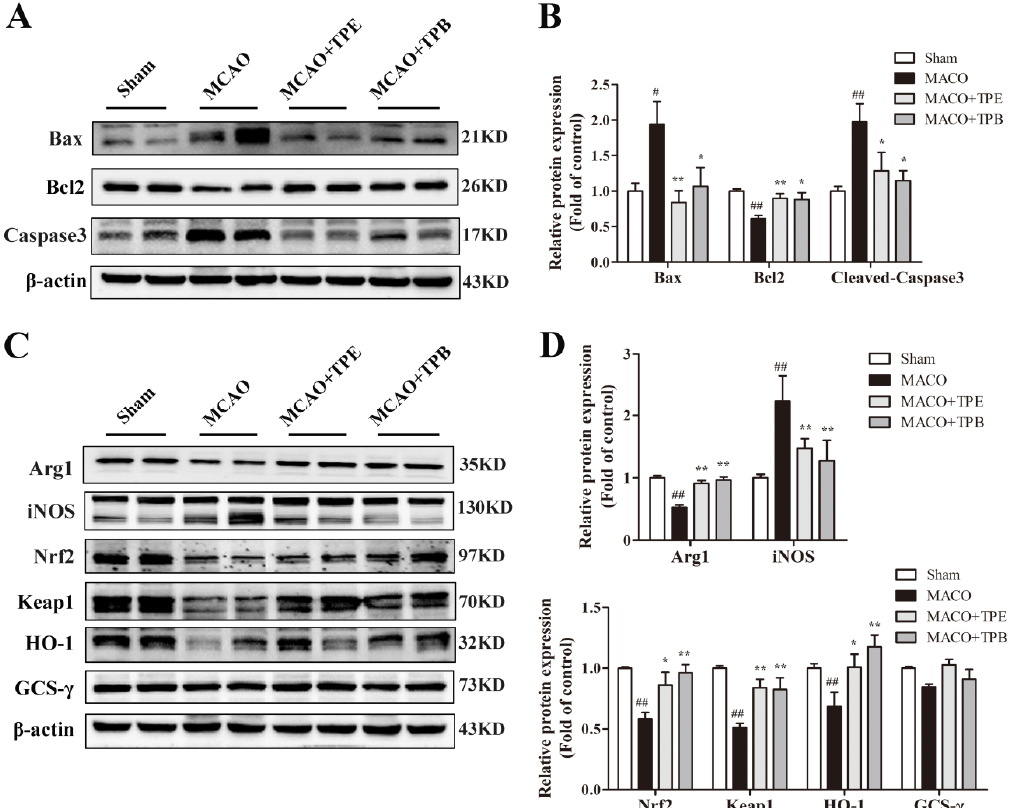
Figure 8. TPE and TPB reduced the cell apoptosis after cerebral ischemia/reperfusion injury by stimulating the Nrf2/HO-1 signaling pathway. ( A ) Effects of TPE and TPB on the expression of Bax, Bcl2, Caspase 3. ( C ) Effects of TPE and TPB on the expression of Arg1, iNOS, Nrf2, Keap1 HO-1,